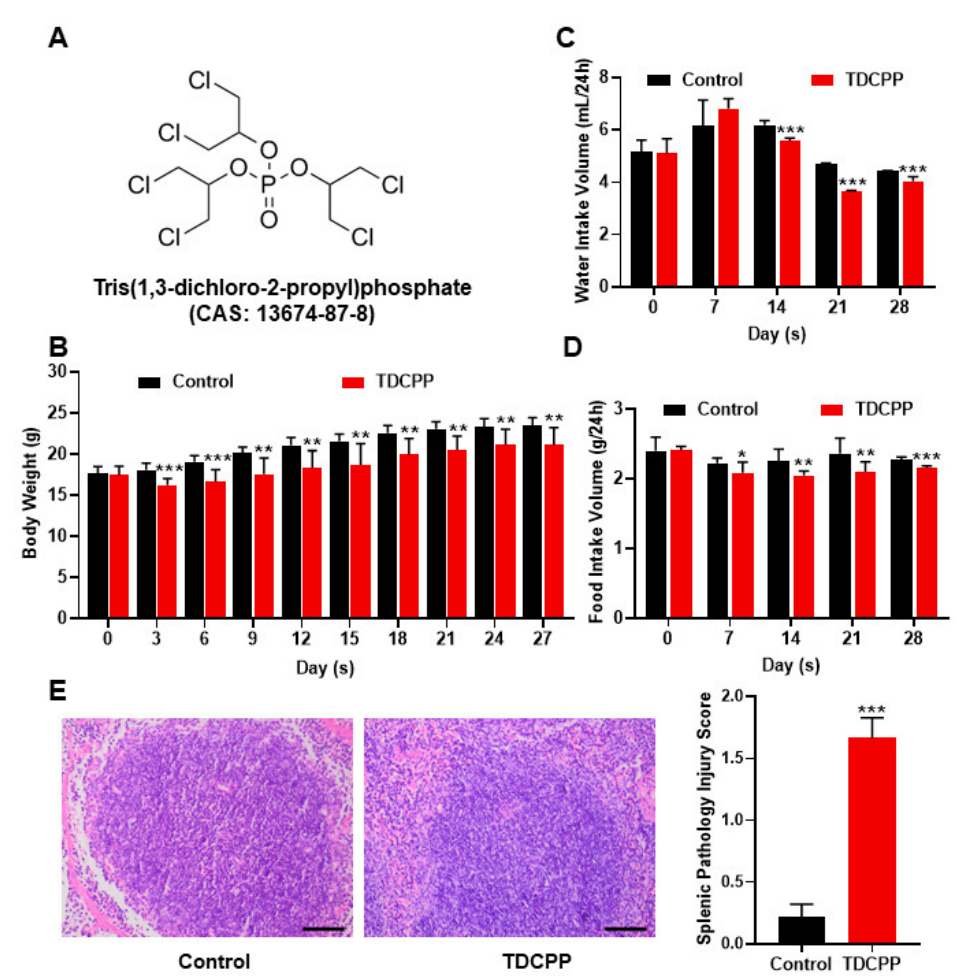
Figure 1. Oral exposure to TDCPP caused systematic response and induced splenic damage. ( A ) Chemical structural formula of TDCPP. ( B ) Body weights of mice in each group were measured on days 0, 3, 6, 9, 12, 15, 18, 21, 24 and 27 under oral administration of 0 or 300 mg/kg TDCPP per day for 28 consecutive days. ( C ) Measurement of 24 h water intake on days 7, 14, 21 and 28 of TDCPP exposure. ( D ) Twenty-four-hour food intake was measured at days 7, 14, 21 and 28 of TDCPP expo- sure. ( E ) Examination of the effect of TDCPP on spleen histomorphology by fluorescence micros- copy of H&E staining of spleen tissue. * p < 0.05, ** p < 0.01, *** p < 0.001 comparing with control group.